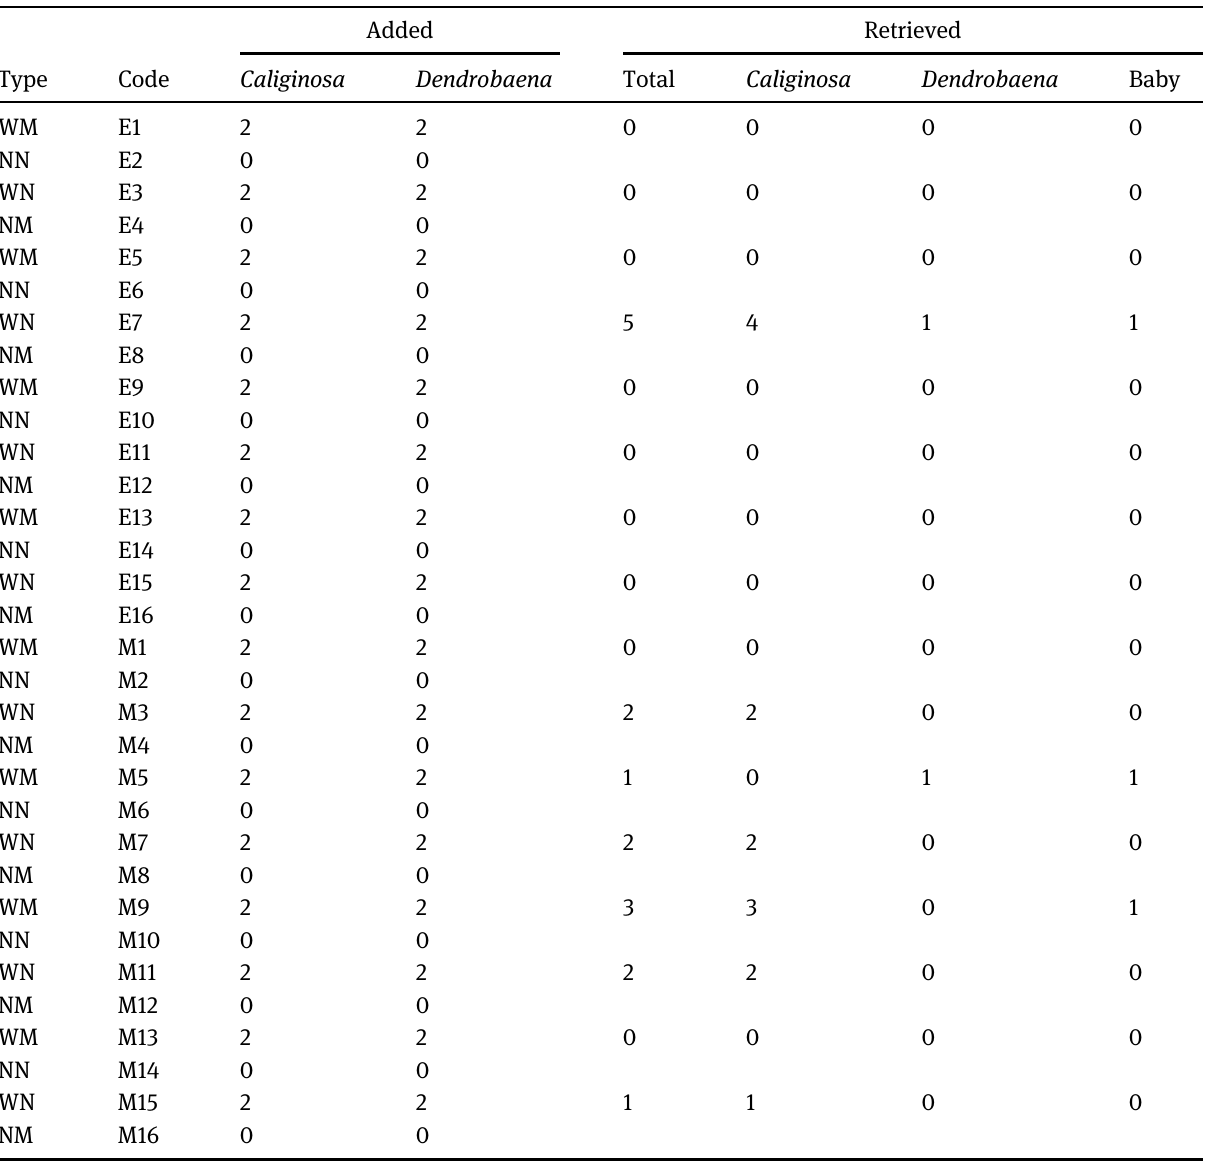
Table 2: Number of worms added and retrieved.